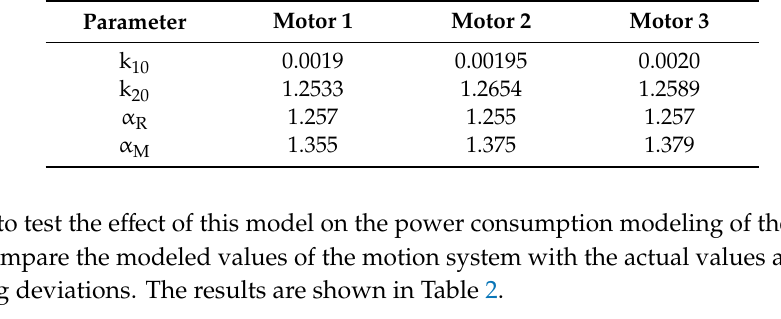
Table 1. TOMR drive wheel parameters.